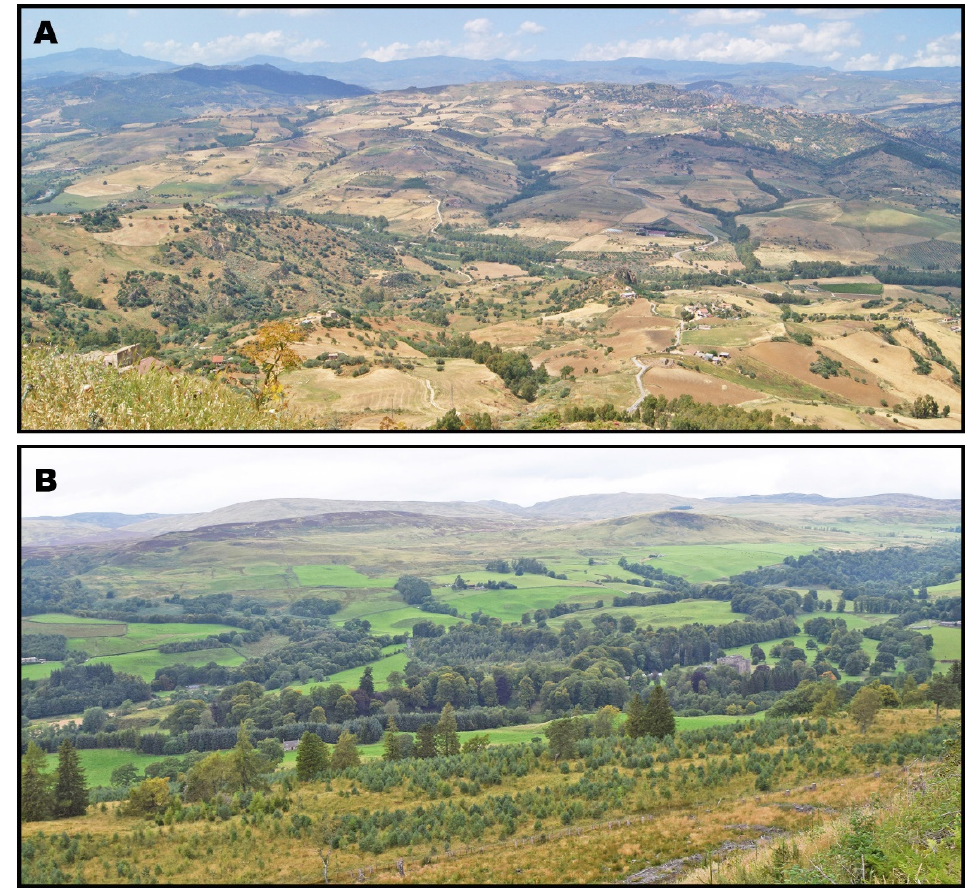
Figure 8. Natural landscape colors: high similarity of the map of Sicily ( A ) and the map of Scotland ( B ), (compare the photographs with Figure 1 and Figure 9).